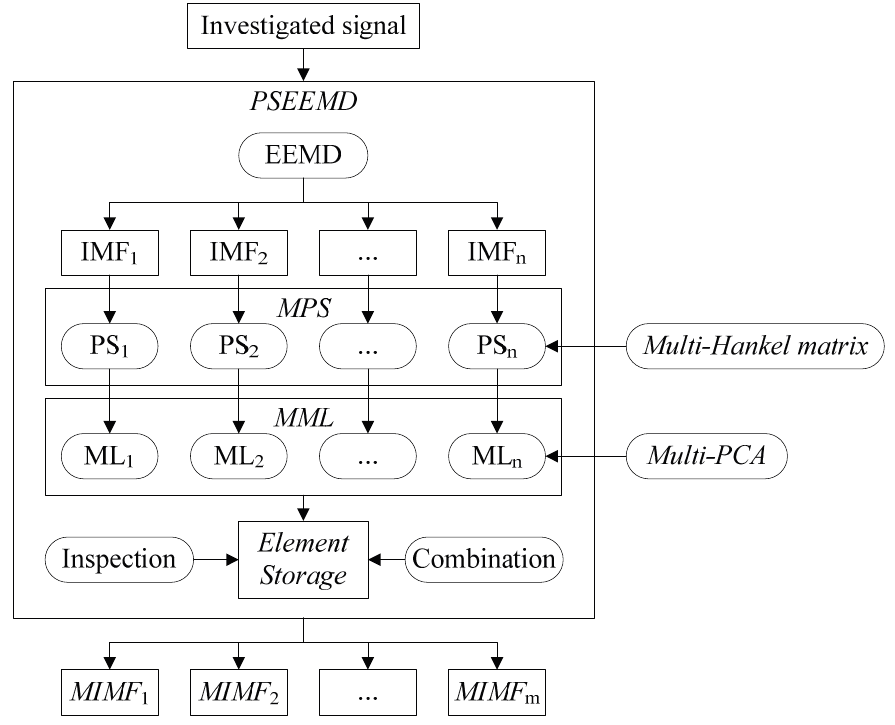
Figure 2. Flow of Phase Space Ensemble Empirical Mode Decomposition